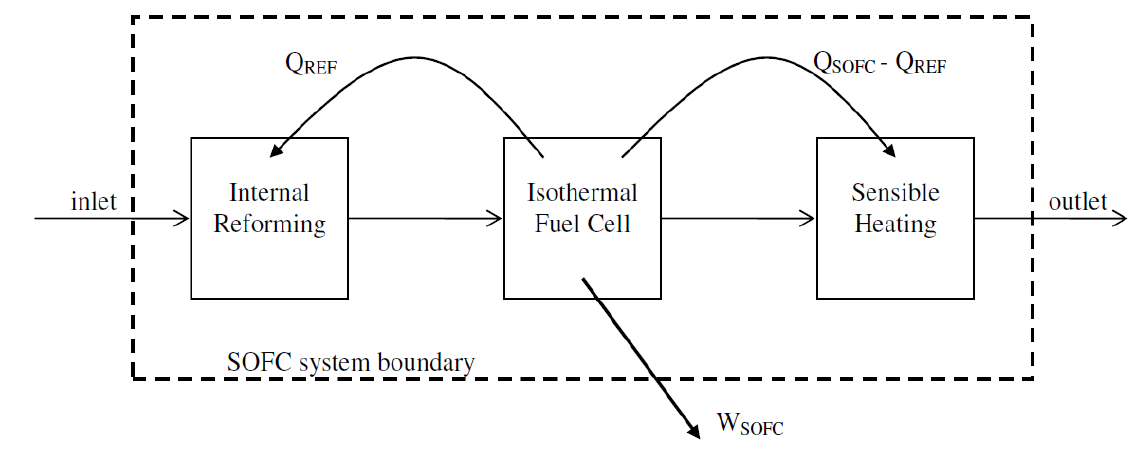
Figure 2. Fuel cell thermodynamic